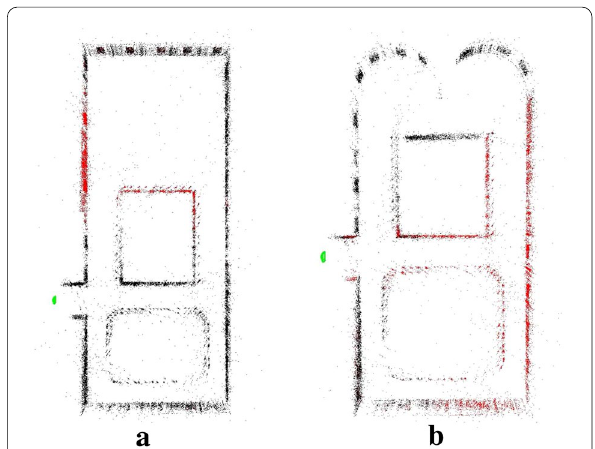
Fig. 7 Feature-based map from monocular SLAM. a The environment for dealing with degeneracy in the direction of translation, b The environment for dealing with degeneracy in the direction of rotation